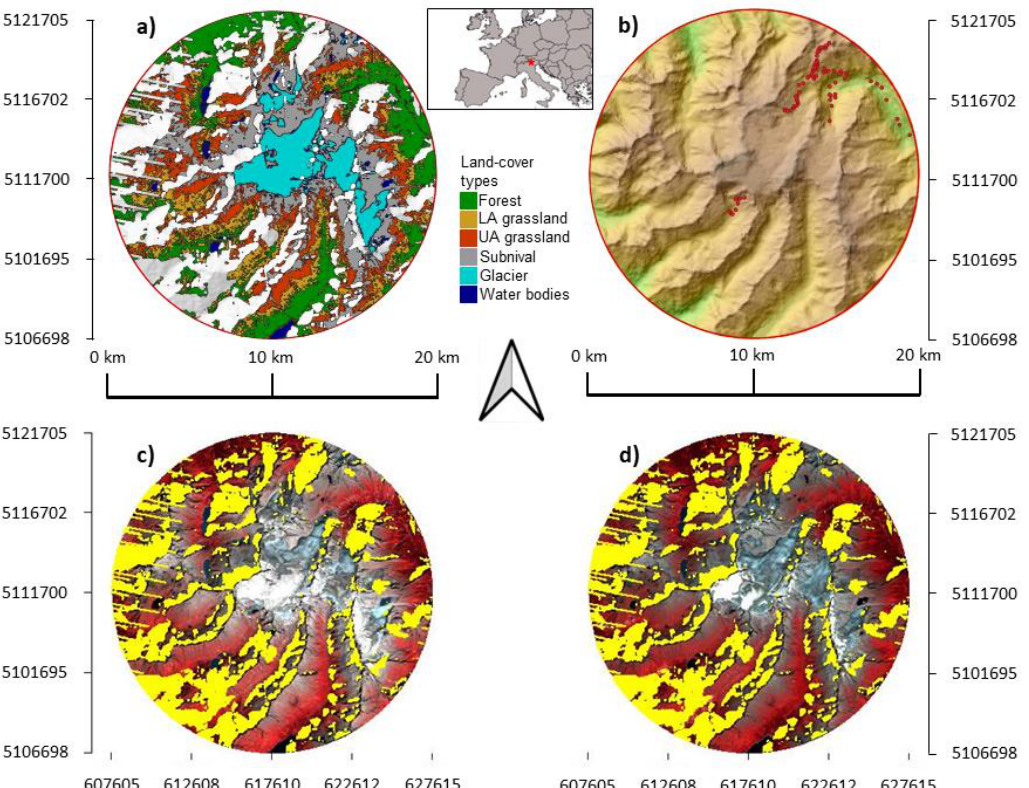
Figure 1. Location of the study area. The circular area of 10 km radius centered in the Adamello glacier (Geographic coordinate system WGS84: 10.52 E, 46.15 N) is shown with ( a ) the distribution of land-cover types derived from the hard classification of the latest Landsat image (2016); ( b ) reliefs highlighted by a green-brown color gradient with vegetation plots represented by red dots; the ( c ) earliest (1987) and ( d ) latest (2016) images of the time series are shown using false-colors images (green, red, near-infrared bands). Unreliable pixels not considered in the analyses due to shadows and snow occurrences are highlighted in yellow.